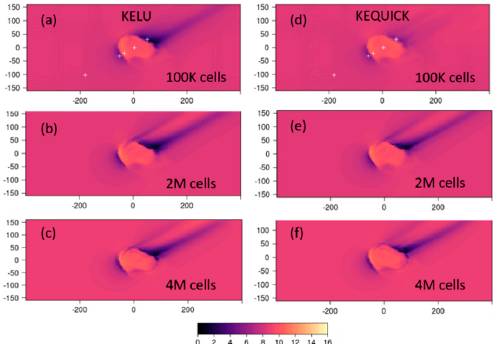
Figure A1. CFD-predicted wind speeds in m s − 1 at 5 m above ground level over Bolund Hill for Case 3, using ( a ) KELU with 100K cells; ( b ) KELU with 2M cells; ( c ) KELU with 4M cells; ( d ) KEQUICK with 100K cells; ( e ) KEQUICK with 2M cells; ( f ) KEQUICK with 4M cells. White crosses in the top panels indicate measurement locations. Axes labels are in